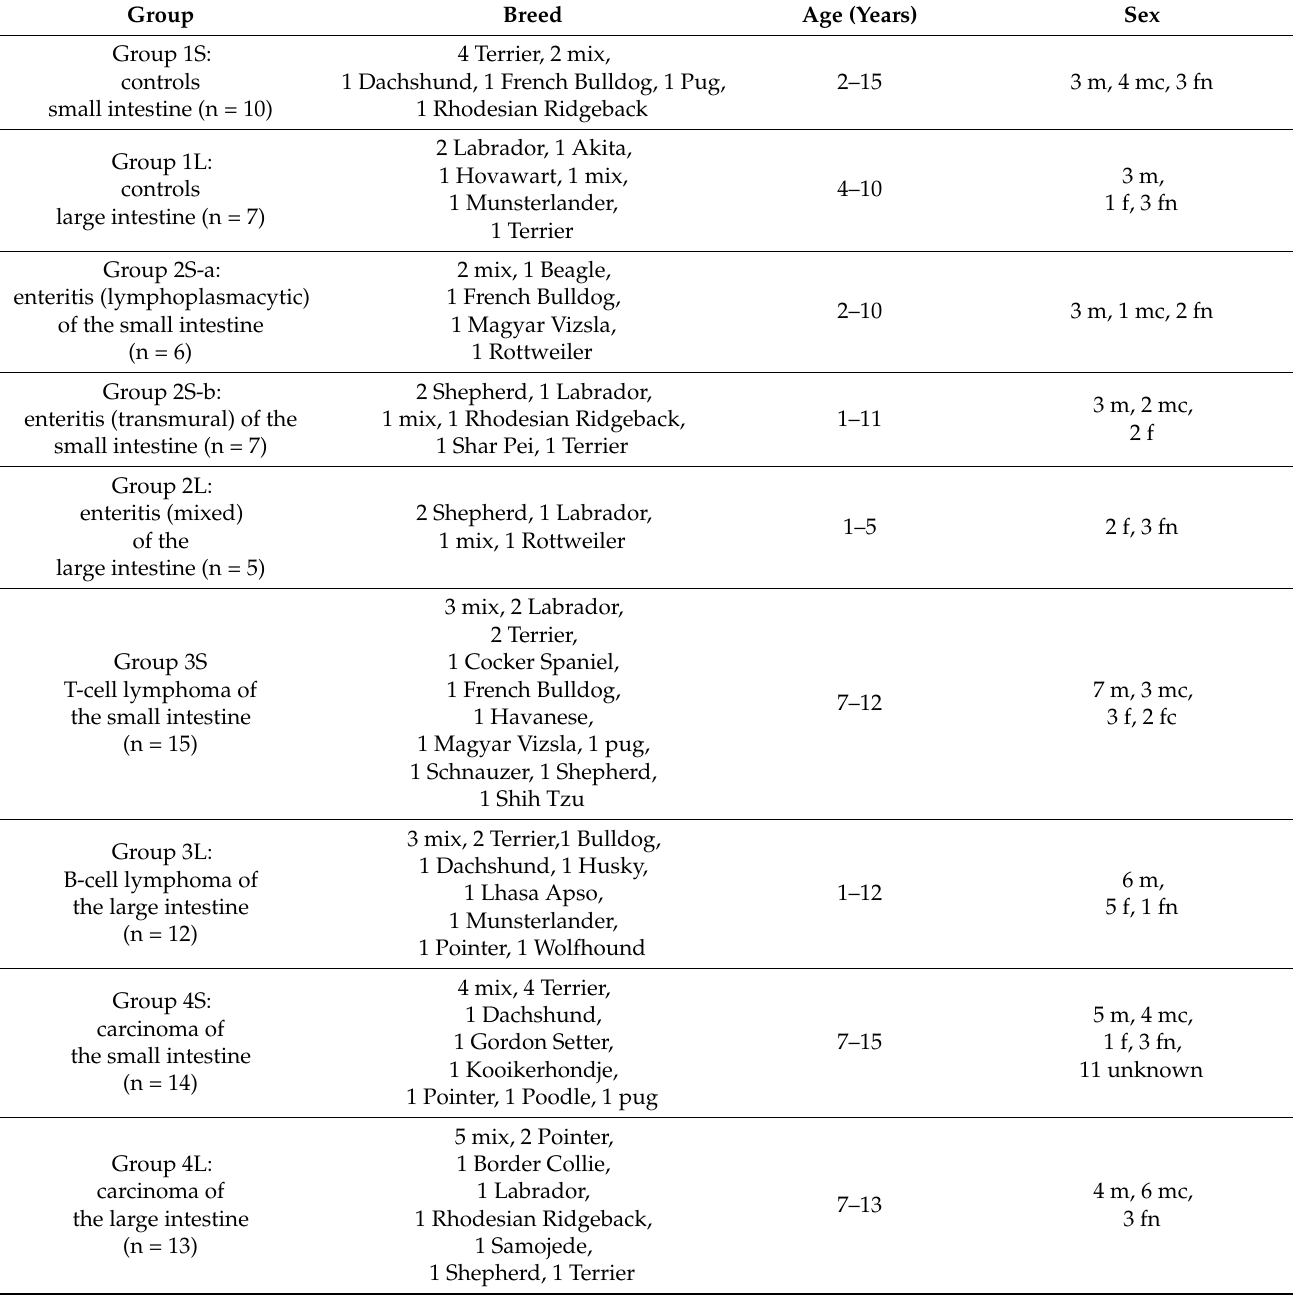
Table 1. Signalment of the dogs included in the miRNA analysis study ( n = 89).